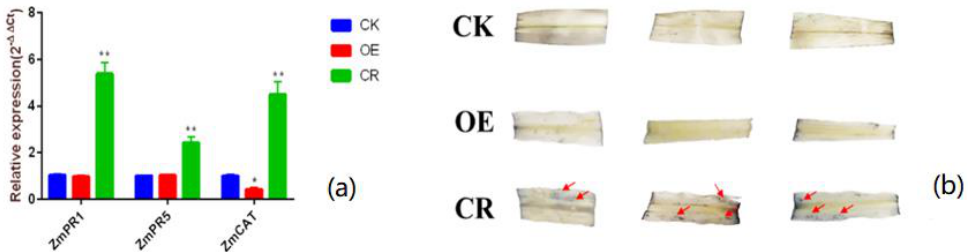
Figure 5. ZmBON3 mediates the production of maize autoimmunity. ( a ) Expression of disease- course-related protein genes and ROS-accumulation-related genes; ( b ) NBT staining of maize leaves. The relative expression levels with significant differences were marked with * (* p ≤ 0.05, ** p ≤ 0.01); part of the red arrow points to the pigmented spots. CK: control plants; OE: transgenic plants overexpressing the ZmBON3 gene; CR: ZmBON3 -gene-edited plants.